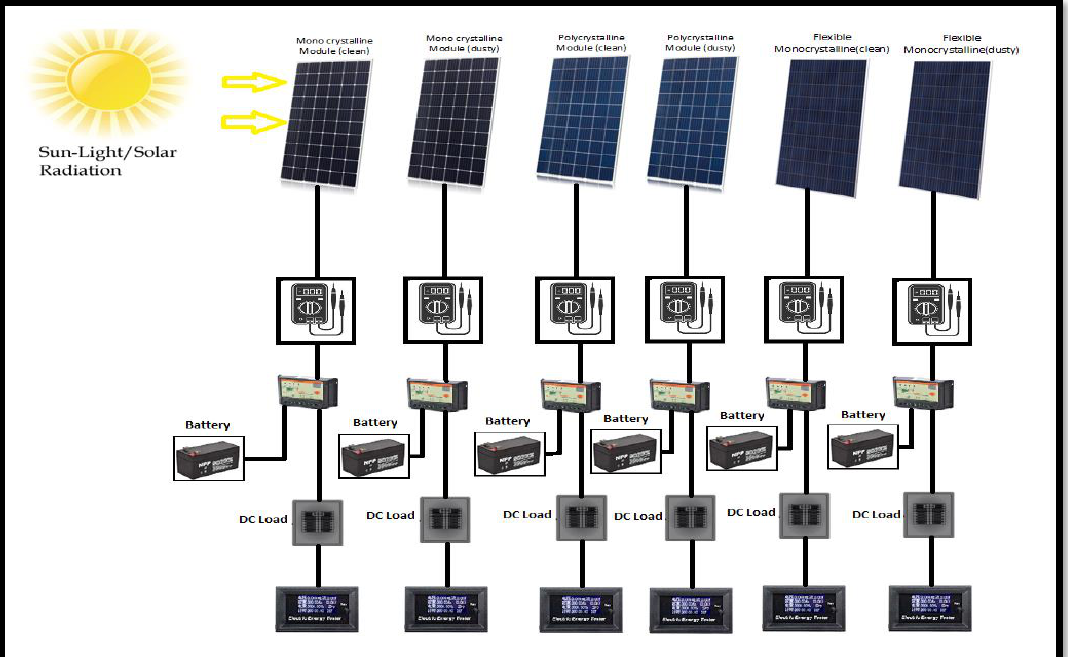
Figure 3. Schematic of stand-alone photovoltaic systems.